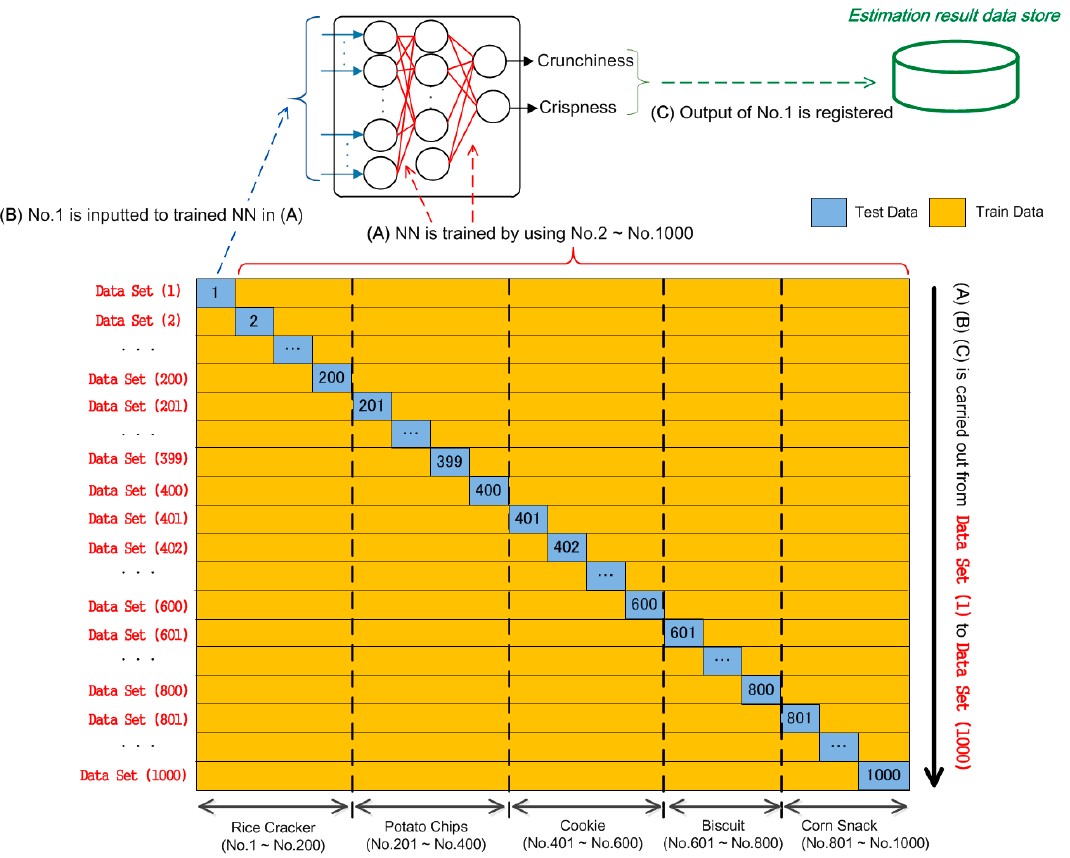
Figure 11. Schematic of the leave-one-out cross-validation.